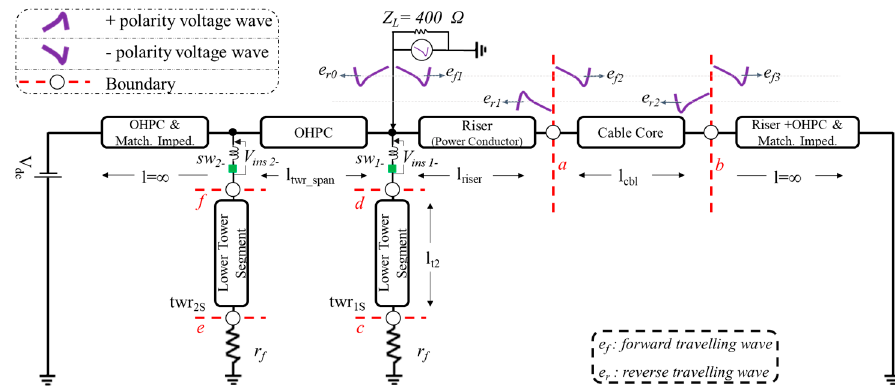
Figure 8. An equivalent circuit of a mixed HVDC transmission line for analysis of direct lightning strikes on overhead power conductors (OHPCs) at a negative pole (only the two towers closest to the sending end of the cable are shown) (description of symbols is provided in Table 1). [15].